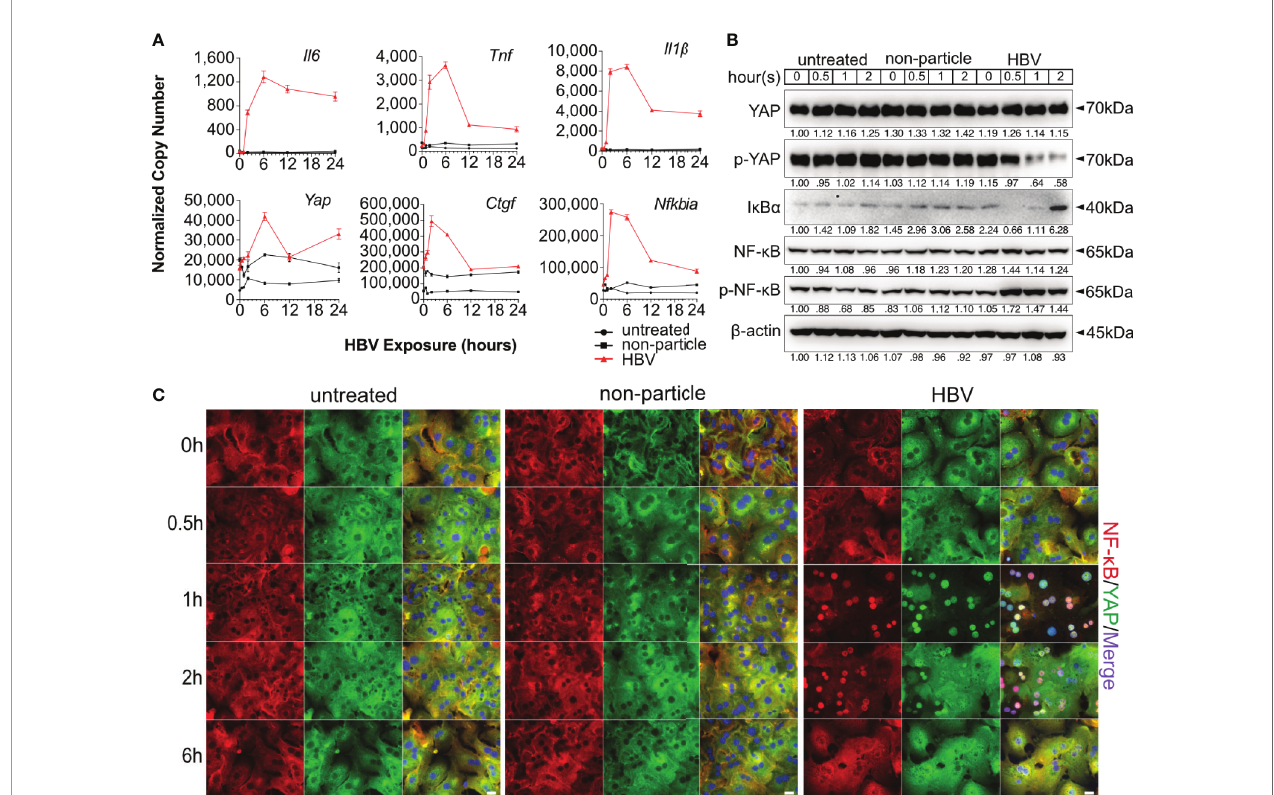
FIGURE 2 | Hippo and NF- k B signaling are induced by HBV exposure in primary murine hepatocytes. Primary murine hepatocytes (PMHs, n=3) were treated with cell culture-derived HBV (MOI of 1,000) or non-particle control for different time points. Gene expression of Il6, Tnf, Il1 b , Yap, Ctgf and Nfkbia was determined by quantitative PCR (A) , (normalized to Actb , mean ± SEM). Western blotting was performed to detect YAP, phosphorylated YAP, I k B a , NF- k B and phosphorylated NF- k B in HBV-exposed PMHs. Gel images were obtained with ADVANCED Fluorescence and ECL Imager, representative of n=3 independent experiments (B) . Representative ICC staining was performed and obtained with Zeiss AxioObserver.Z1 and Apotome (40x objective) to visualize YAP (green) and NF- k B (red) localization, raw images were subsequently proceeded with Image J software, representative of n=3 independent experiments (C) . Scale bar, 20 m m; kDa,